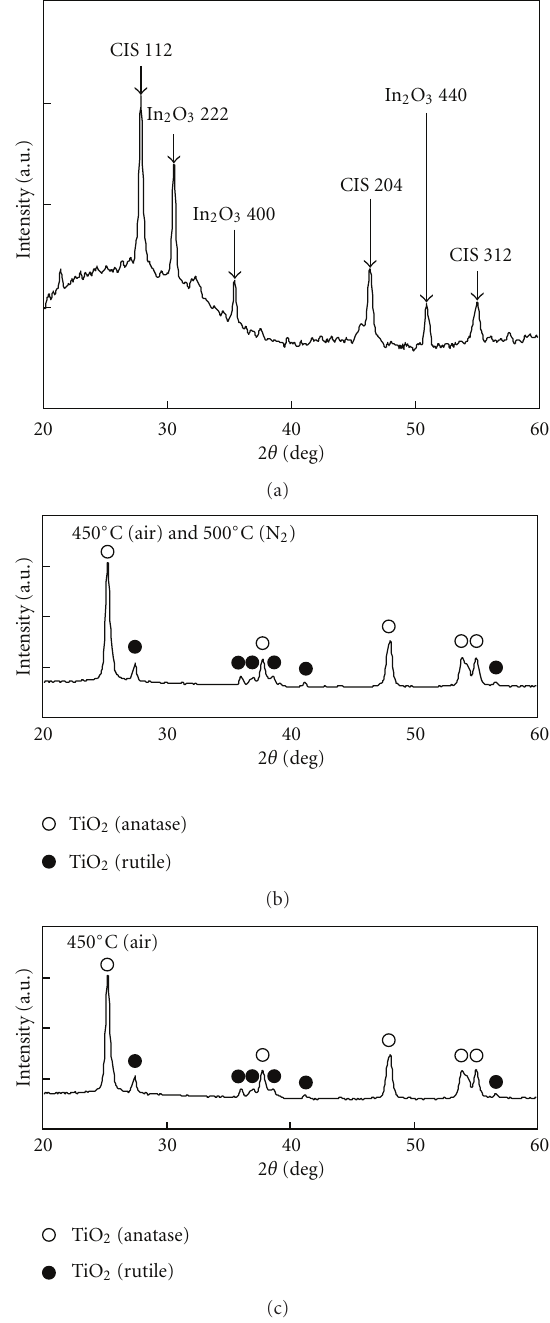
indicate an anatase phase with a tetragonal system, and there was a slight amount of the rutile phase. The particle size of the anatase phase was estimated to be 26.1 nm from the Scherrer’s equation. No di ff erences between Figures 3(b) and 3(c) were observed on the crystalline structures of the TiO 2